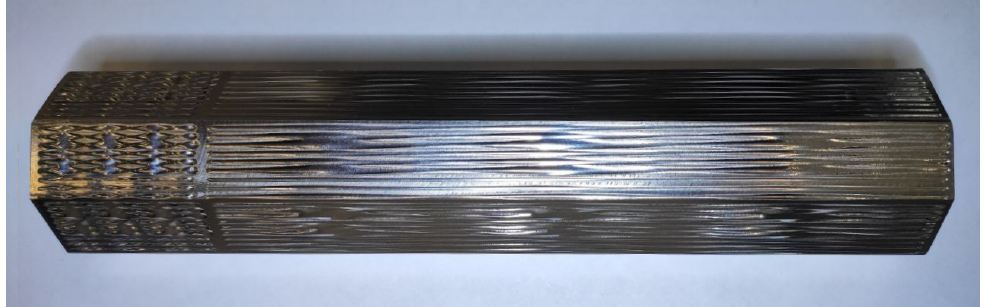
Figure 4. Octagonal Ti-6Al-4V alloy sample with textured single lines on the